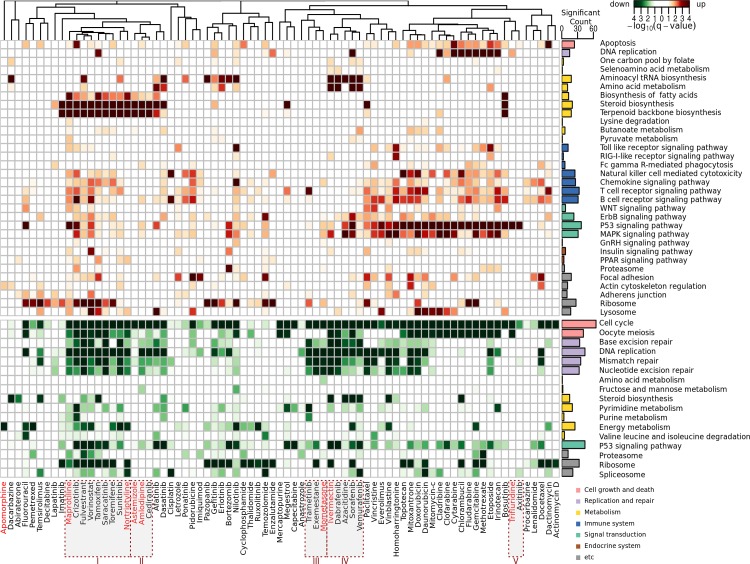
Cluster analysis of DR candidates with other cancer drugs using their pathway enrichment patterns.The eight DR candidates and 69 cancer drugs in the LINCS dataset were clustered using the 32 up- and the 17 down-regulated pathway enrichment patterns. The eight DR candidates (red) belong to five clusters (I ~ V) with 15 cancer drugs. The bar plot on the right side shows the number of significantly enriched cancer drugs (q-value<0.05) for the corresponding pathway. The significance of up- and down-regulation is presented in red and green, respectively.